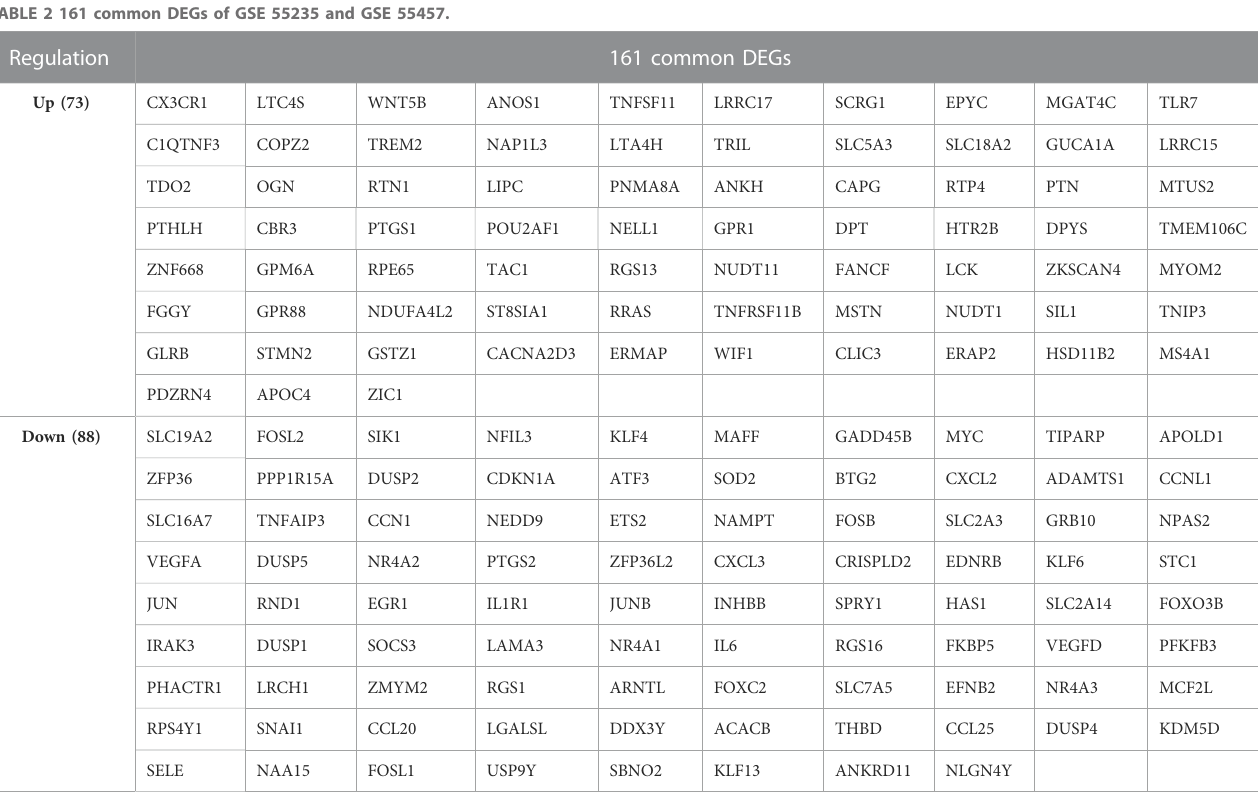
TABLE 2 161 common DEGs of GSE 55235 and GSE